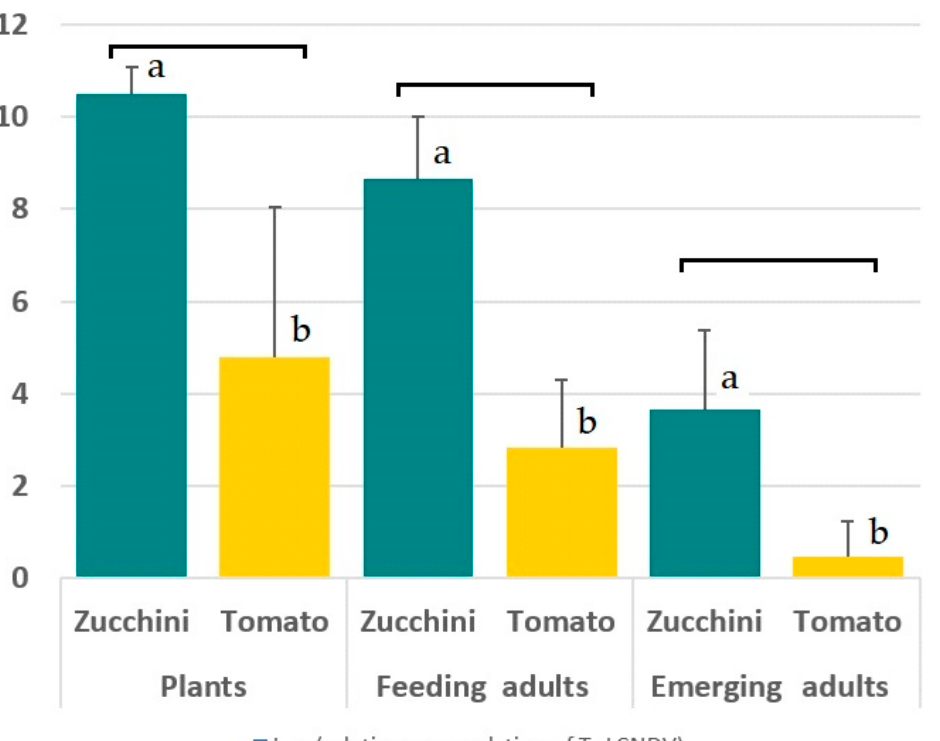
Figure 1. Log-transformed ToLCNDV accumulation in infected zucchini and tomato plants, in B. tabaci adults feeding on infected plants, and in adults emerging from pupae that were collected from dried leaves of infected zucchini and tomato plants. The mean values of 50 replicates in each group; the bars represent S.D. The letters represent the statistical significant difference ( p < 0.05) using the Wilcoxon test.